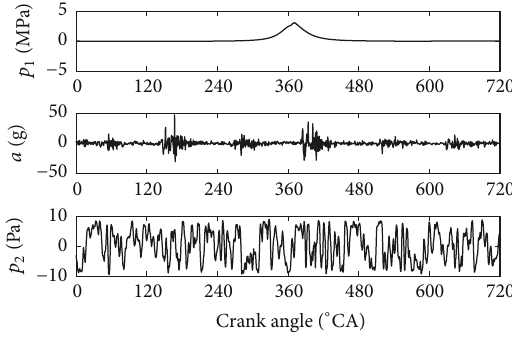
Figure 10: Cylinder pressure, cylinder head vibration acceleration, and cylinder body side near-field radiated noise signals.